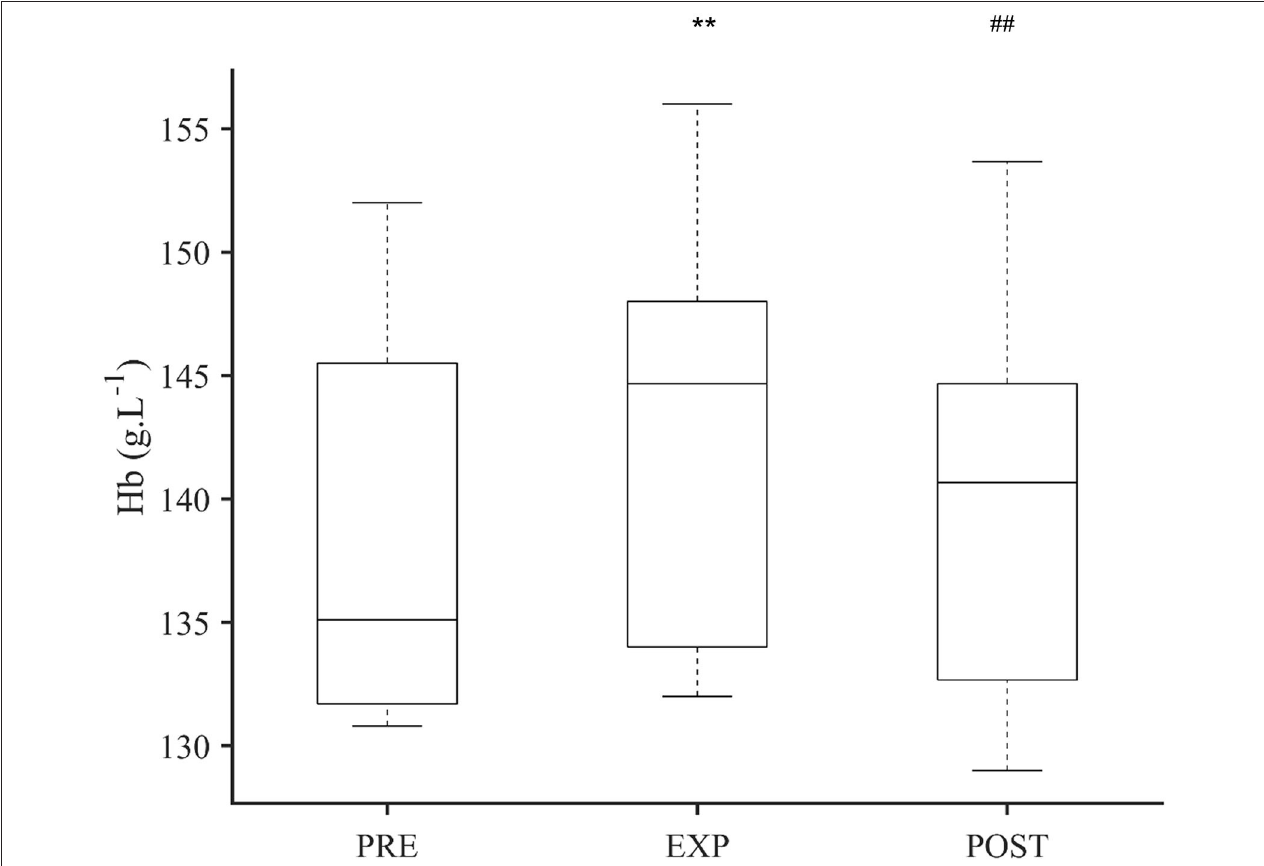
FIGURE 3 | Boxplot of hemoglobin concentration (Hb) after 5min normoxic breathing (PRE), 10min hypoxic breathing of 10.0% O 2 (EXP), and 10min hyperoxic breathing of 100% O 2 (POST) for n = 14. Significant difference from PRE is indicated by ** for P < 0.01 and from EXP is indicated by ## for P < 0.01. There was no difference between PRE and POST.